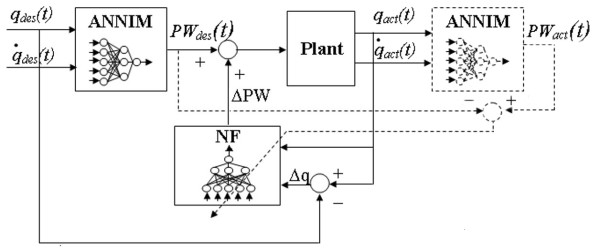
NF Training scheme. Scheme used to collect the training set of NF. The training output signal of NF is the difference between PWact and PWdes and not the PWact as it was wrongly indicated in figure 2 of the original paper.